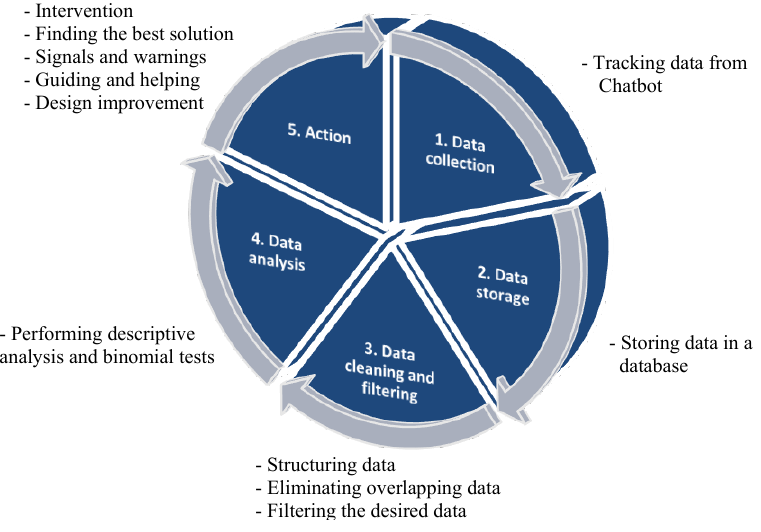
Fig. 6. Model of Learning